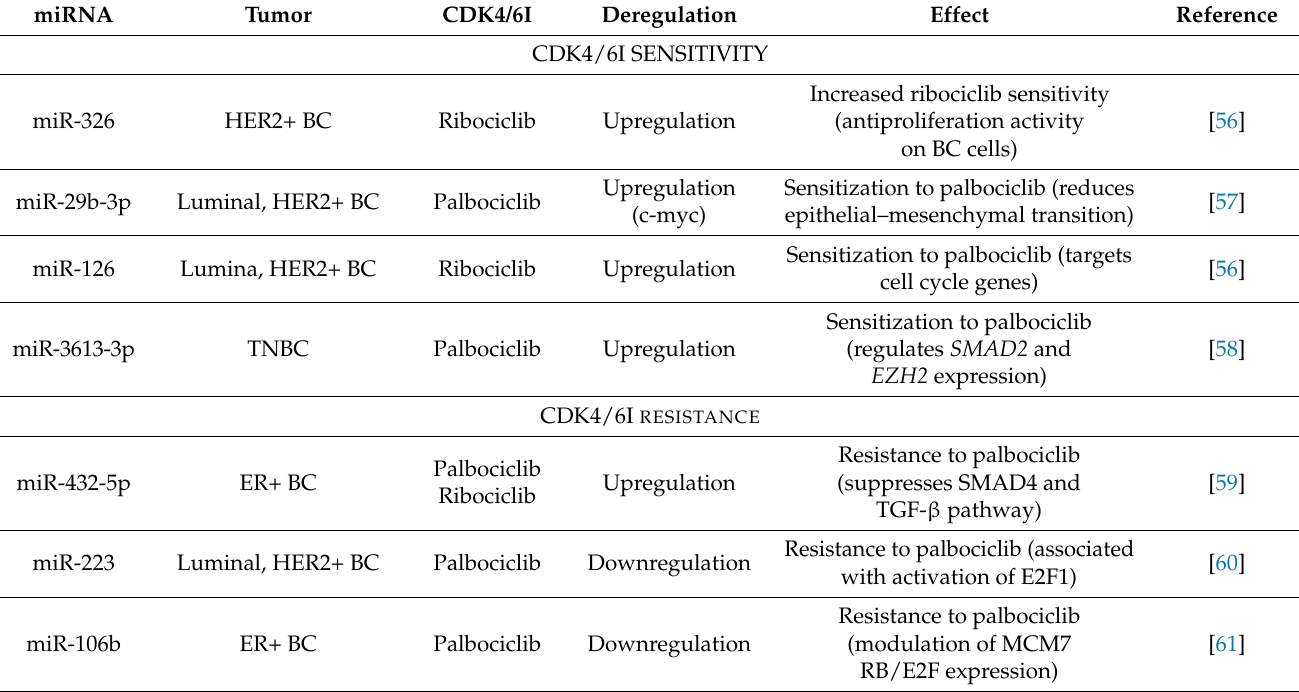
Table 1. Summary of studies on miRNA predictors for CDK4/6 inhibitor (I) response or